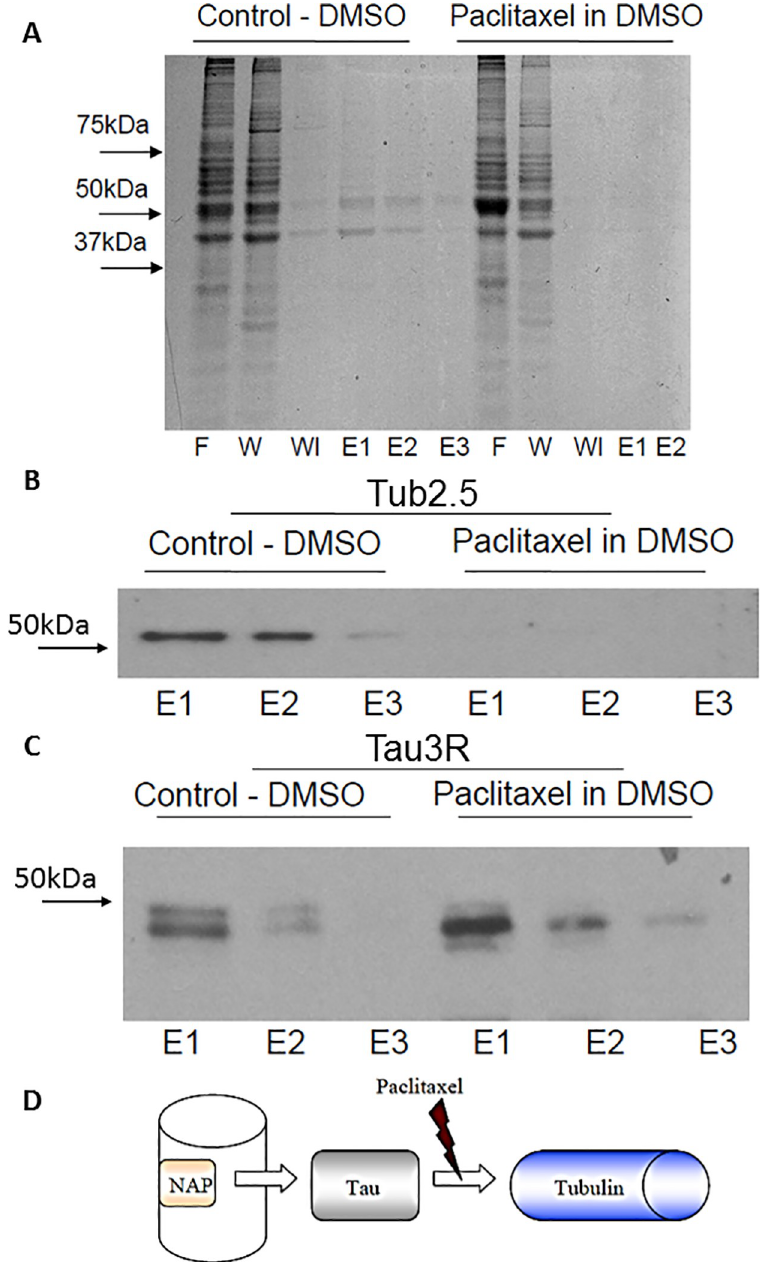
Fig 3. NAP interaction with tubulin, but not with Tau, is inhibited by paclitaxel. (A) Bio-SafeTM Coomassie protein staining of the different fractions (F–flow-through, W—first wash, Wl—last wash, E1/2/3 –elution fractions by order) obtained from NAP-affinity column loaded with protein extracts of newborn rat cerebral cortex with 4 mg paclitaxel, dissolved in 80 μ l DMSO, or equal volume of DMSO, alone. Almost no tubulin is evident in the elution fractions in the paclitaxel column, in contrast to the control one. ( B, C ) Western analysis of elution fractions obtained similarly as in panel (A). (B) Tubulin is not detected in the elution fractions of the pre-incubated paclitaxel column in comparison to the control column. (C) Tau3R is observed in the elution fractions of both the pre-incubated paclitaxel column and the control column. (D) Graphic depiction of the hypothesis that NAP, bound to an affinity column, interacts with tubulin throughout mediation of